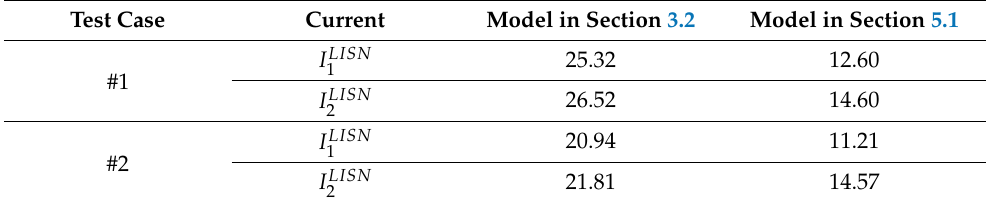
Table 3. MAEs of the current curves shown in Figures 13, 14, 17 and